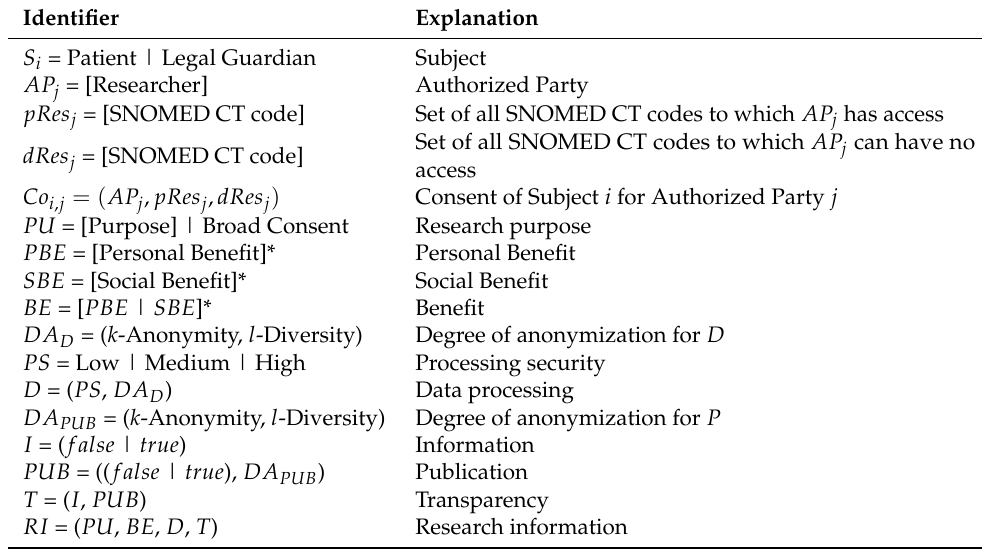
Table 2. Identifiers for the Sovereign Digital Consent